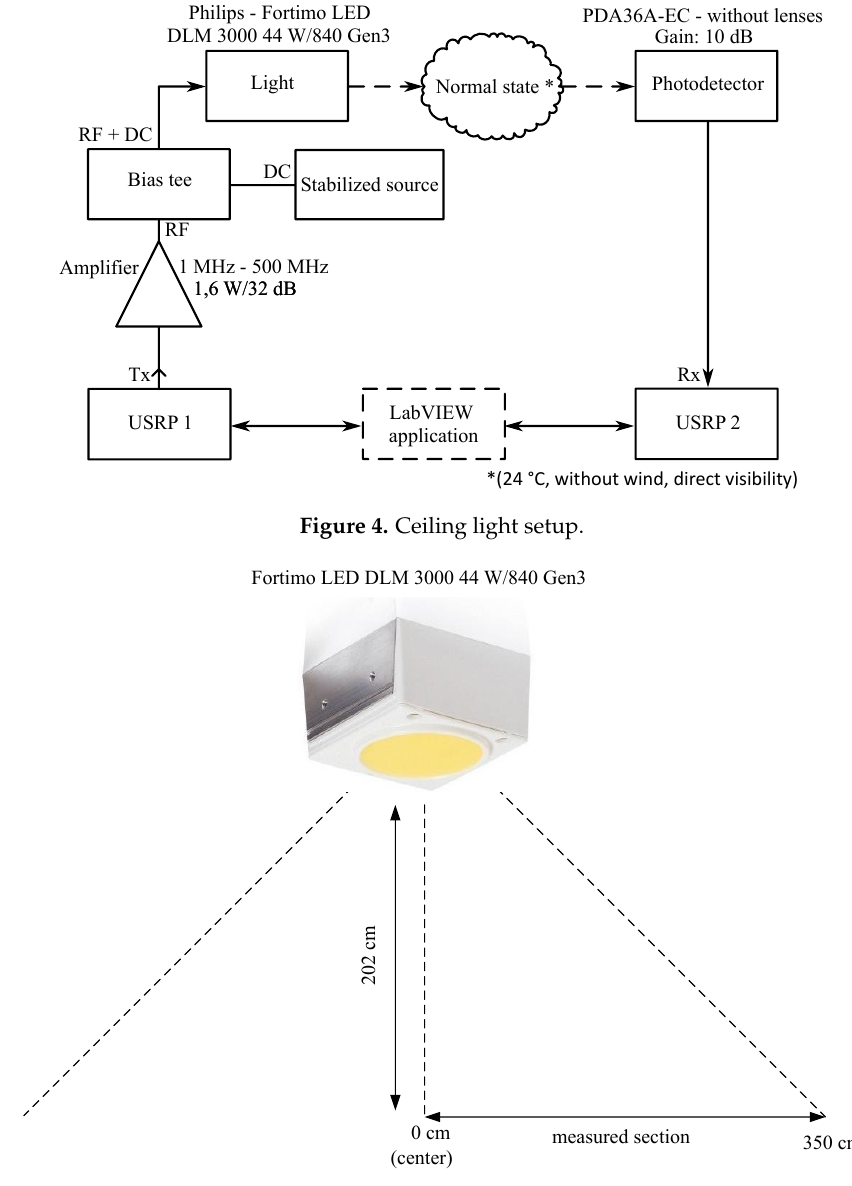
Figure 5. Setup with measured